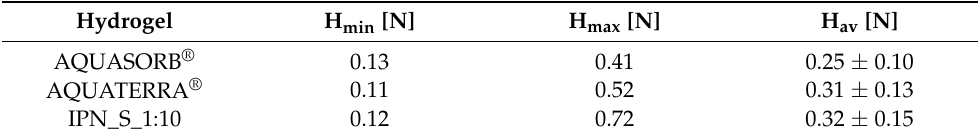
Table 3. Hardness (H): minimum, maximum and average, obtained via compression test. Hydrogel H min [N] H max [N] H av [N] AQUASORB ® 0.13 0.41 0.25 ± 0.10 AQUATERRA ® 0.11 0.52 0.31 ± 0.13 IPN_S_1:10 0.12 0.72 0.32 ±